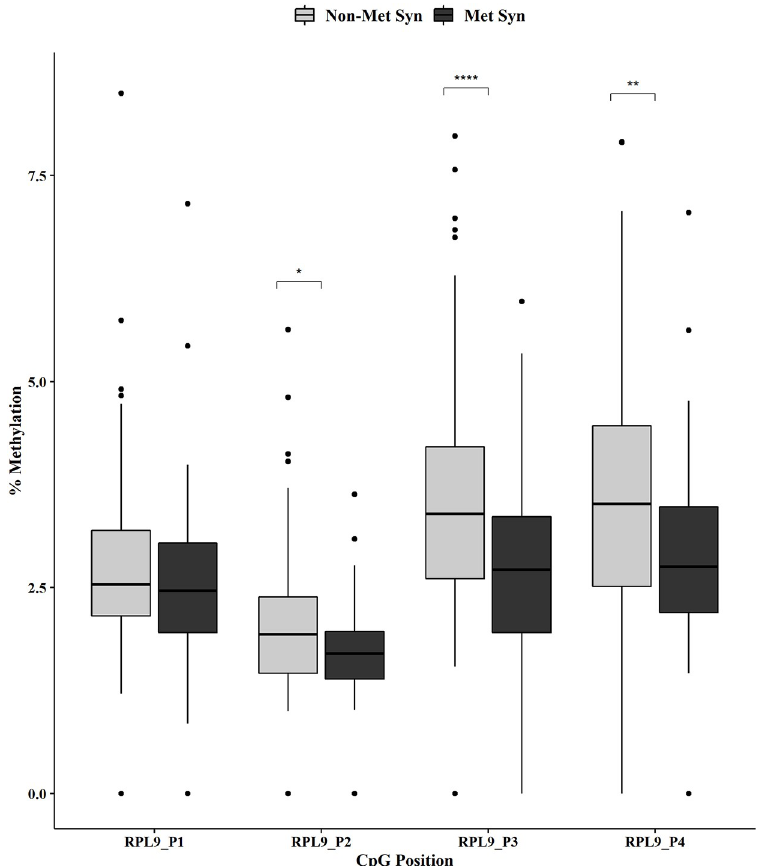
Fig 3. RPL9 promoter DNA methylation by MetS status. DNA methylation at four CpGs within the promoter of RPL9 was measured in non-MetS (n = 110) and MetS (n = 74). Mann-Whitney U test was used for the statistical comparisons between the non-MetS versus MetS. � p < 0.05, �� p < 0.01, ���� p <